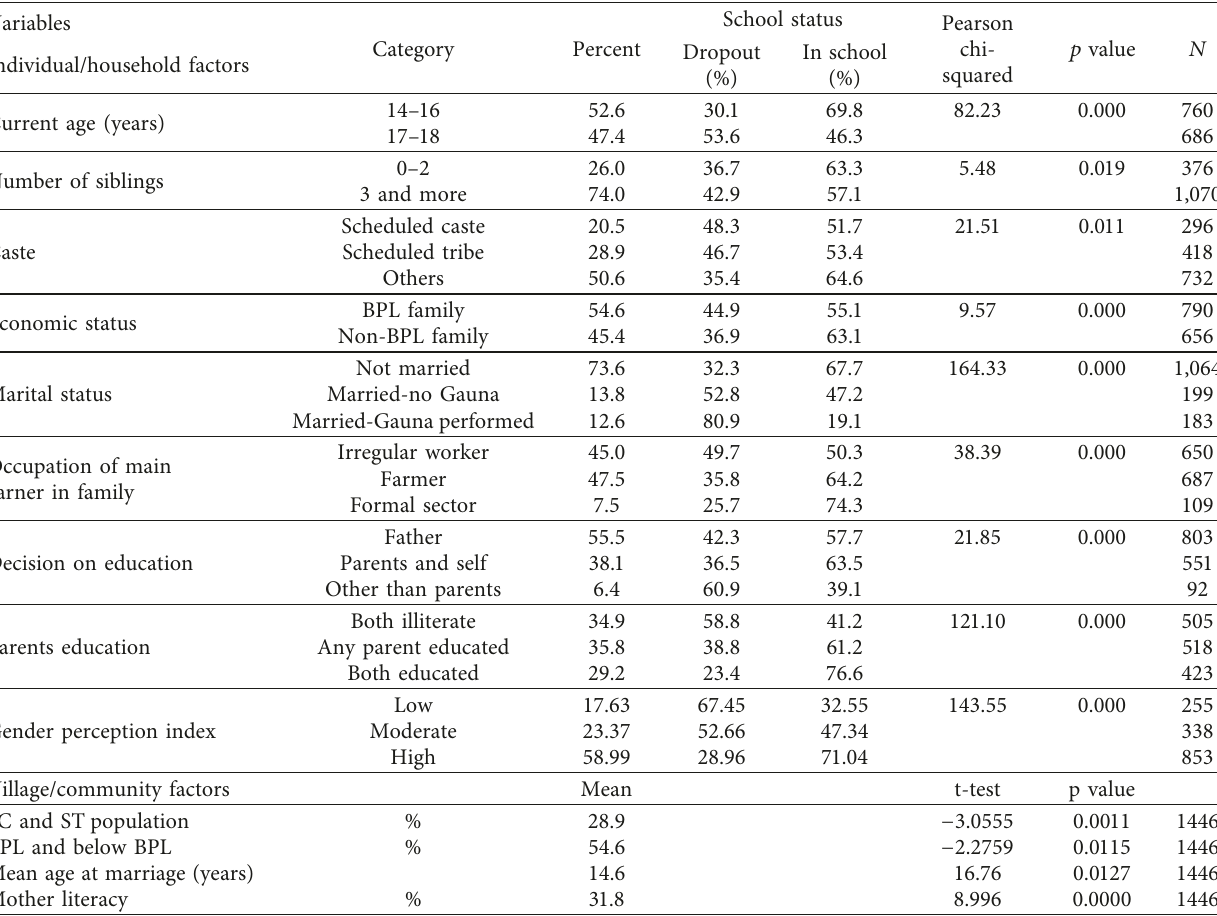
Table 1: Frequency, percent, and chi-square distribution of selected individual and community variables with school status in rural India. Variables